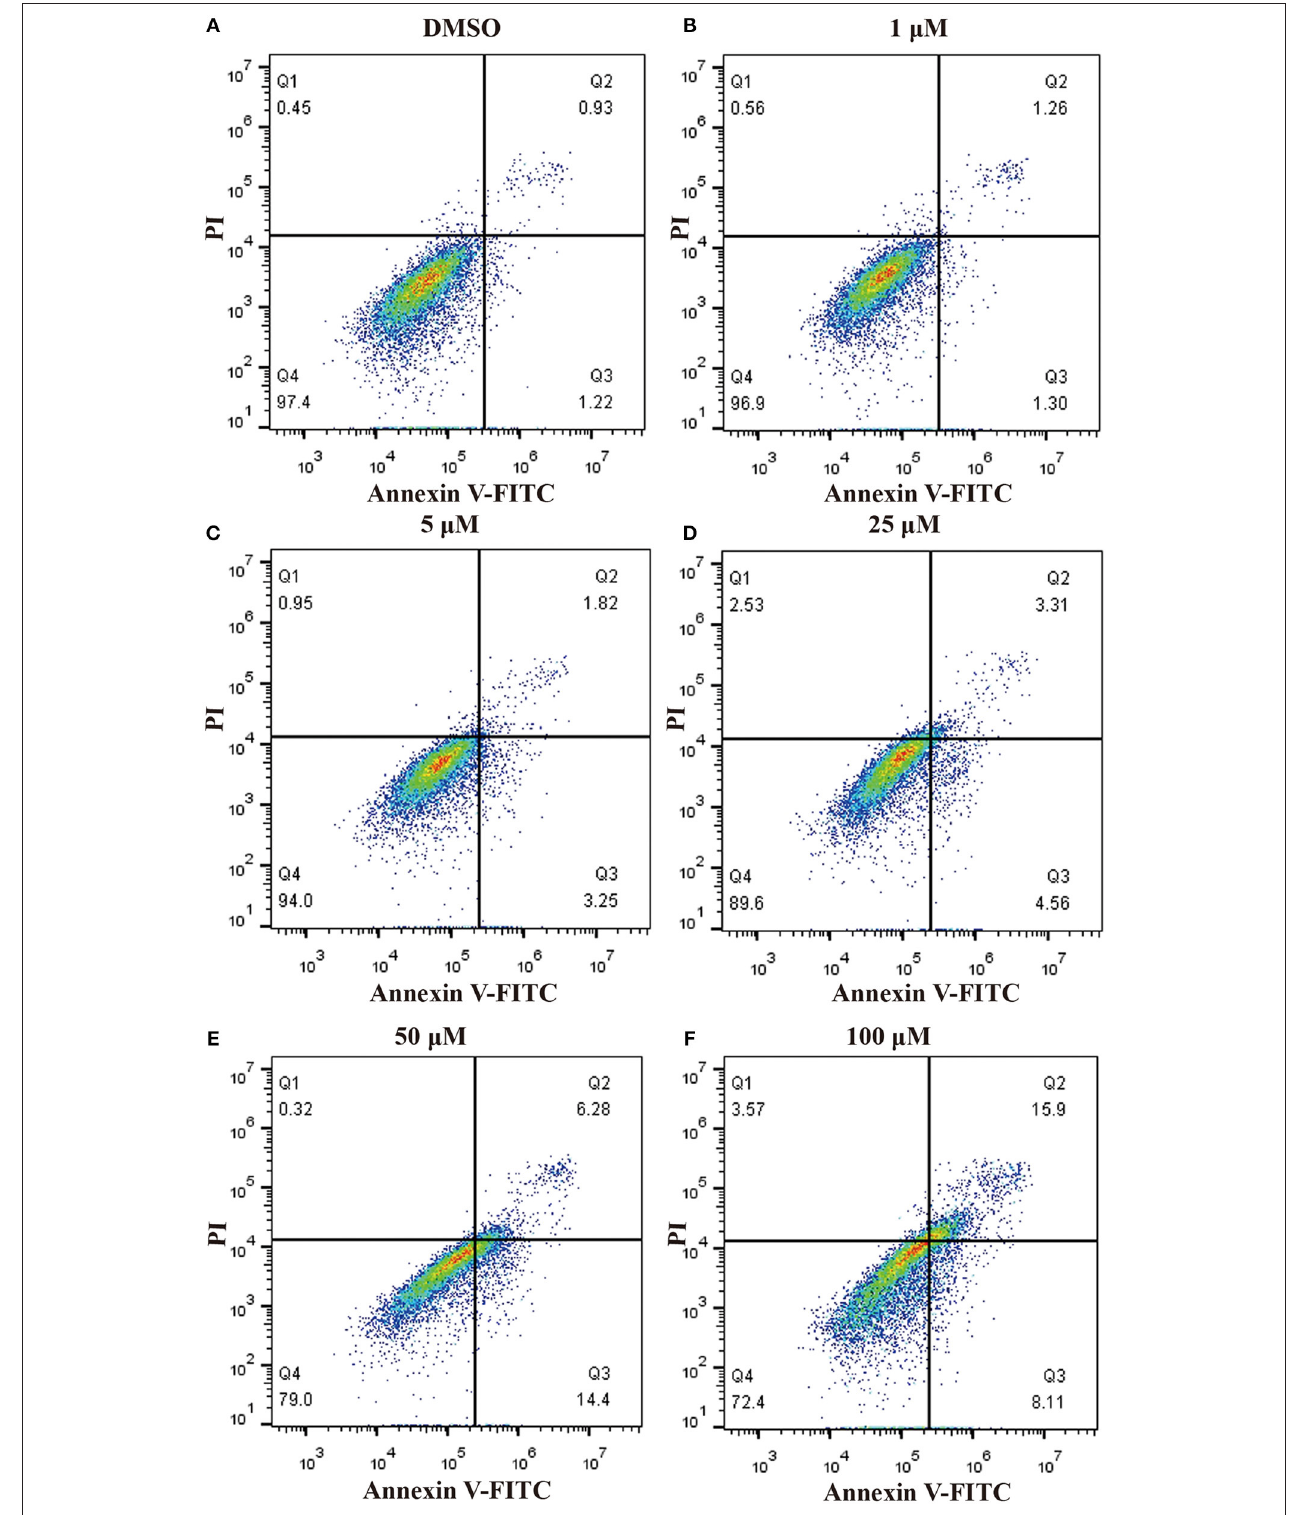
FIGURE 2 | Pterostilbene induced apoptosis in MCF7 cancer cells s. Apoptosis in cells untreated and treated with pterostilbene ( A , control; B , 1 µ M; C , 5 µ M; D , 25 µ M; E , 50 µ M; F , 100 µ M) was evaluated by flow cytometry using Annexin V-FITC/PI staining.